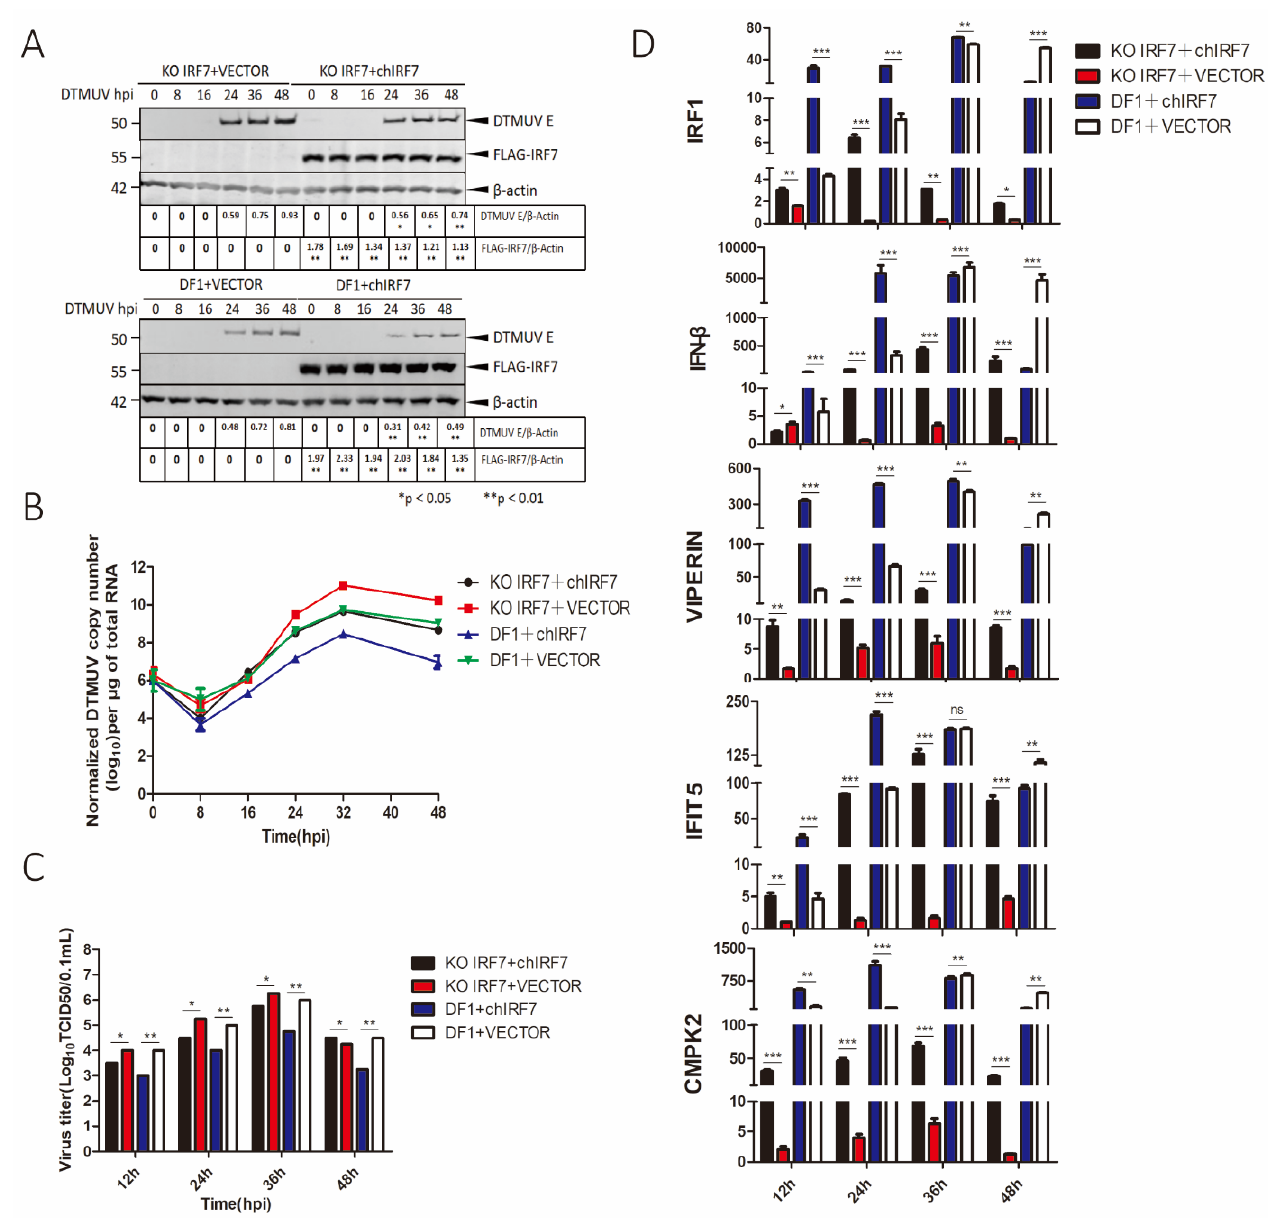
Figure 2. Effects of IRF7-overexpression and -knockout on DTMUV replication and upregulation of IRF1, VIPERIN, IFN- β , IFIT5, and CMPK2. ( A ) Wild type (DF1) and IRF7-knockout (KO IRF7) cells were transfected with a Flag-tagged chicken IRF7 and infected with DTMUV at an MOI of approximately 2. Cells were harvested at 0, 8, 16, 24, 36, and 48 hpi, respectively, and total cell lysats were prepared in parallel. The chiIRF7 expression levels and the replication of DTMUV were assessed by Weston Blot with anti-Flag and anti-DTMUV antibodies. β -actin was detected for a loading control. ( B ) The genomic RNA levels of DTMUV in DF1 and KO IRF7 cells, as in ( A ), were determined by RT-qPCR and presented. ( C ) Viral titers were determined by TCID50 from the extracellular fluids of DF1 and KO IRF7 cells harvested, as in ( A ). Error bar represents the standard error of three replicate experiments. T tests were performed between the IRF7 overexpressed cells and the empty vector transfected cells in DF1 (blue and white) and KO IRF7 (red and black) cells. ( D ) The mRNA levels of IRF1, IFN- β , VIPERN, IFIT5, and CMPK2 from the cells harvested as in ( A ) were detected by RT-qPCR. T tests were performed between the IRF7 overexpressed cells and the empty vector transfected cells in DF1 (blue and white) and KO IRF7 (red and black) cells. (ns, nonsignificant; * p < 0.05; ** p < 0.01; *** p < 0.001 ）